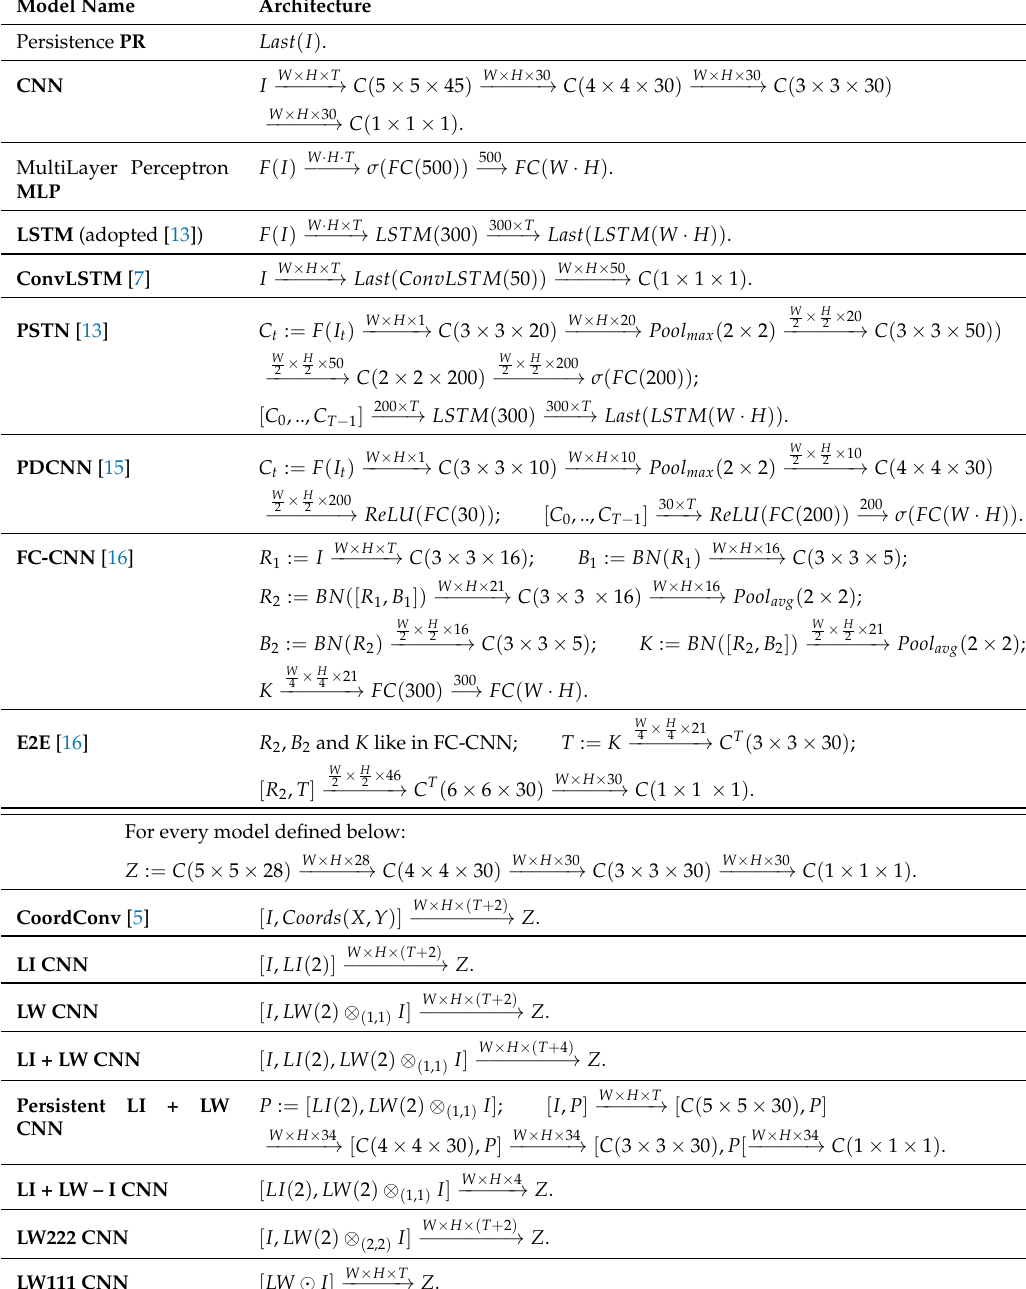
Table 1. Configurations of models used in experiments on real-world data. The localized models follow after the double